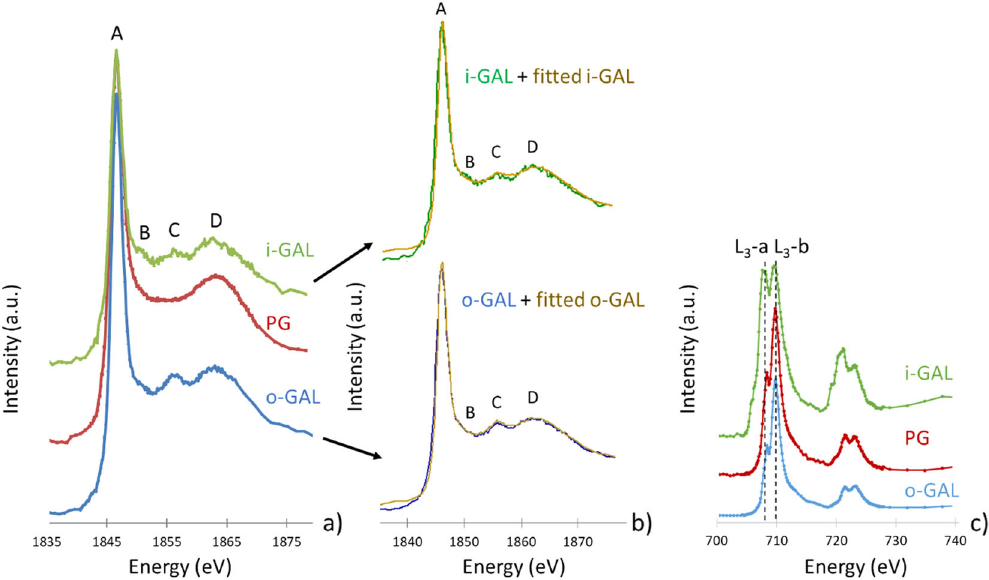
Fig. 5 STXM analyses at Si K and Fe-L edges of the glass alteration layer. a Si K-edge spectra obtained in pristine glass, i-GAL and o-GAL and superposition of i-GAL and o-GAL spectra with corresponding fi tted spectra ( b ). Fe L-edge spectra obtained in pristine glass, i-GAL and o-GAL ( c ).